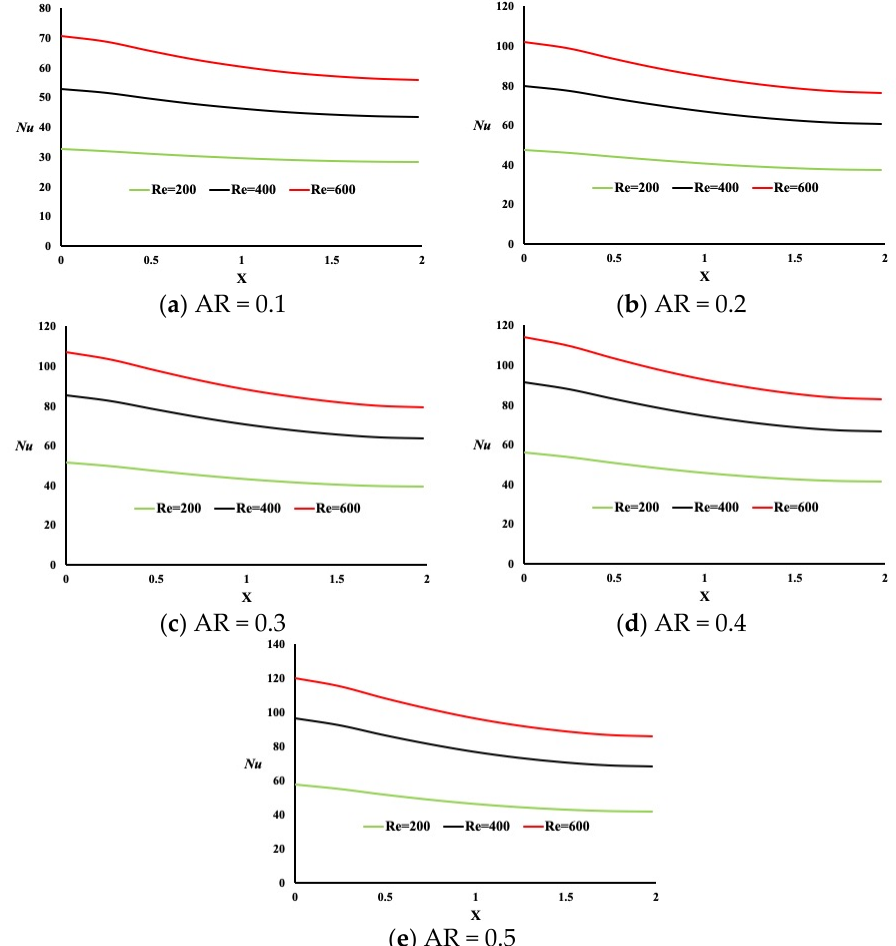
Figure 7. Nusselt number variation for different aspect ratios and flow rates.